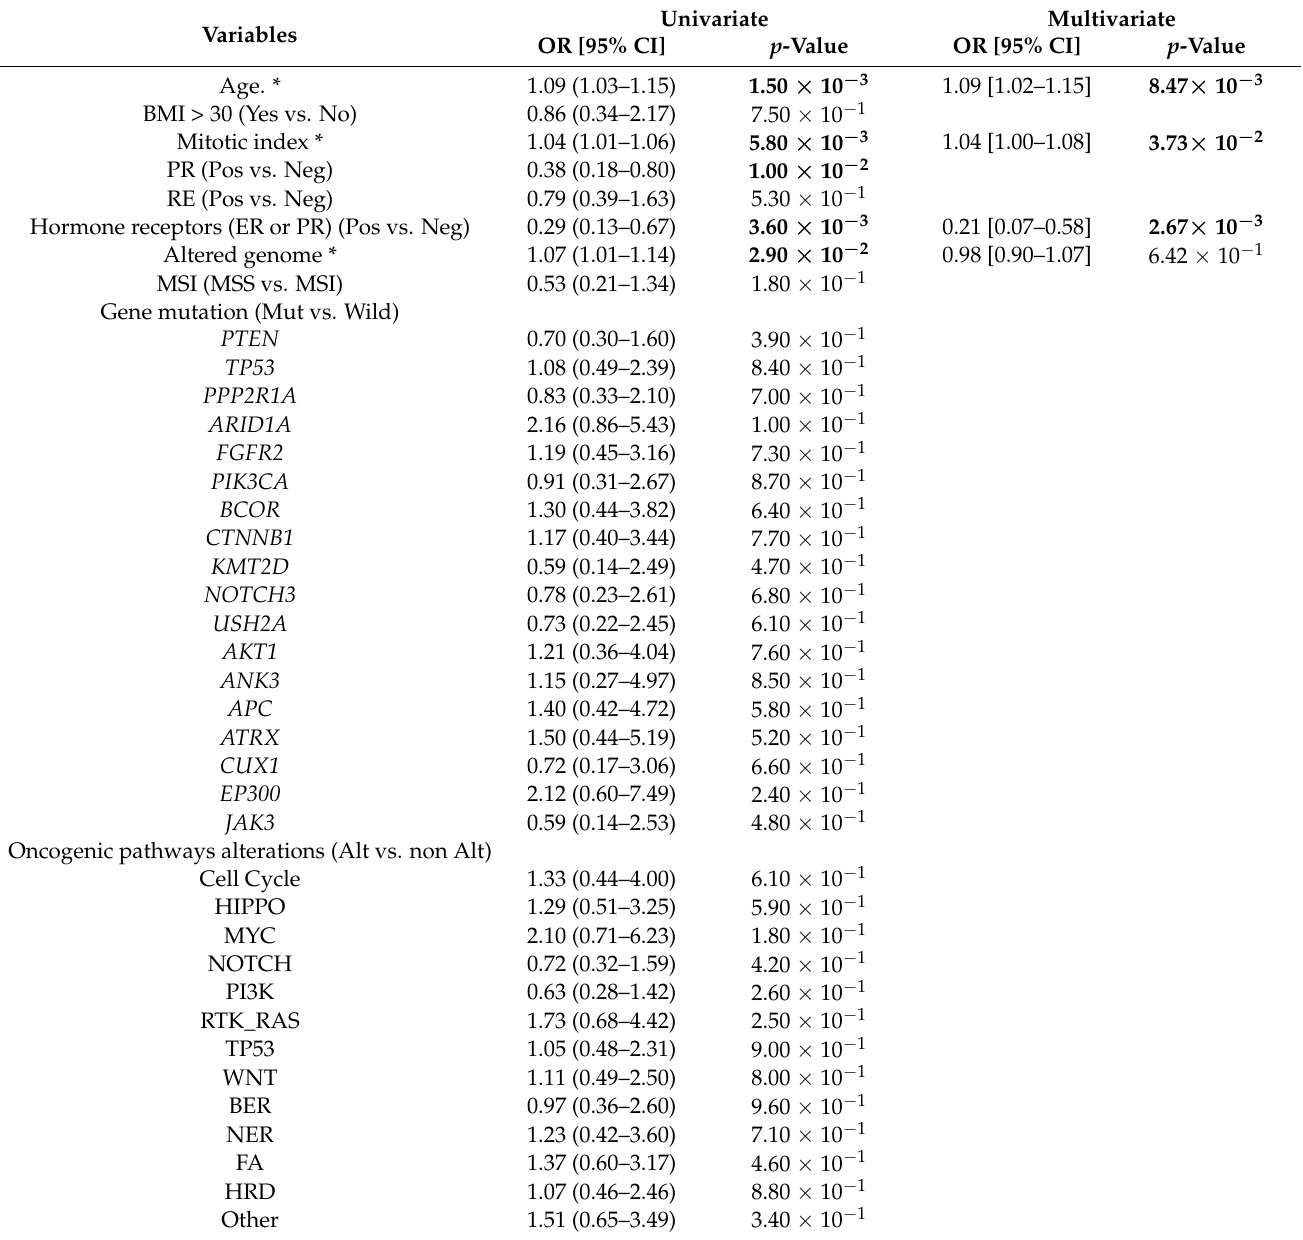
Table 4. Results of univariate and multivariate analyses for